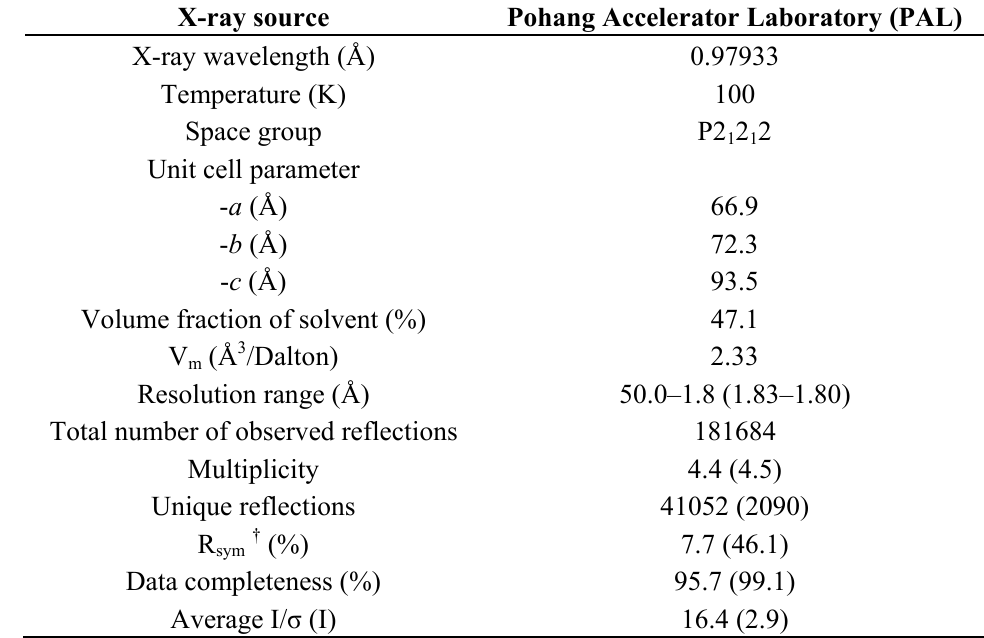
Table 2. Data collection statistics for the mutant Oxi- α crystal. The values in parentheses are for the highest resolution